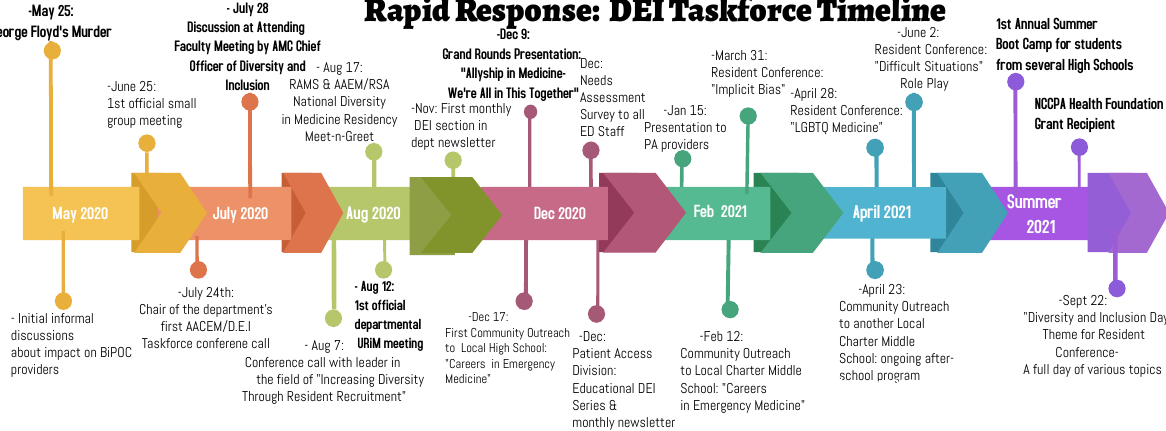
Figure 3. Overview of events sponsored by Albany Medical Center’s Diversity, Equity and Inclusion Taskforce (May 2020-September 2022). DEI , diversity, equity, and inclusion; RAMS , Society for Academic Emergency Medicine Residents and Students; AAEM/RSA , American Academy of Emergency Medicine Resident and Student Association; PA , physician assistant; LGBTQ , lesbian, gay, bisexual, transgender, and queer; NCCPA , National Commission on Certification of Physician Assistants; BIPoC, Black, indigenous and people of color; AACEM , Association of Academic Chairs of Emergency